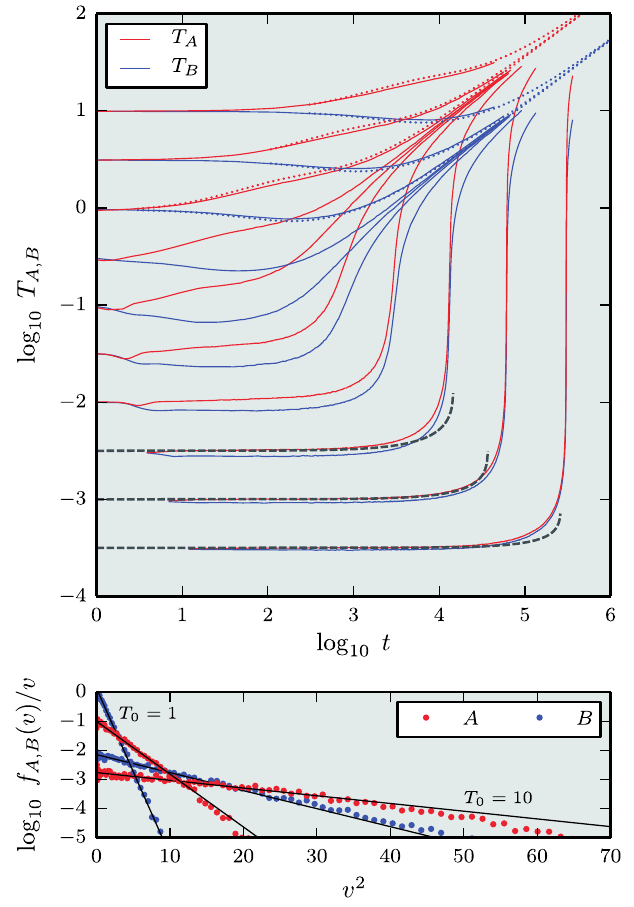
FIG. 1. Growth of the mean kinetic energy in a 2D binary system (no damping). Particles interact via the nonreciprocal Hertzian forces. The upper panel displays the time dependence of the temperatures T A and T B . The solid lines show the develop- ment obtained from the simulations for the areal fraction ϕ ¼ n ¼ 0 . 3 and different initial temperatures T π r 2 0 . All curves 0 approach the universal asymptotes ∝ t 2 = 3 described by Eqs. (9) and (10). The dotted lines represent the solution of Eq. (7) for T ≳ 1 . The early development at T ≪ 1 is fitted by the 0 0 explosive solution (13), shown by the dashed lines. The temper- ffiffiffiffiffiffiffiffiffiffiffiffiffiffiffiffi p mr 2 = φ atures are normalized by φ 0 ; time is in units of . 0 0 The lower panel illustrates the velocity distributions f A;B ð v Þ at 1 and t ≃ 700 for T 0 ¼